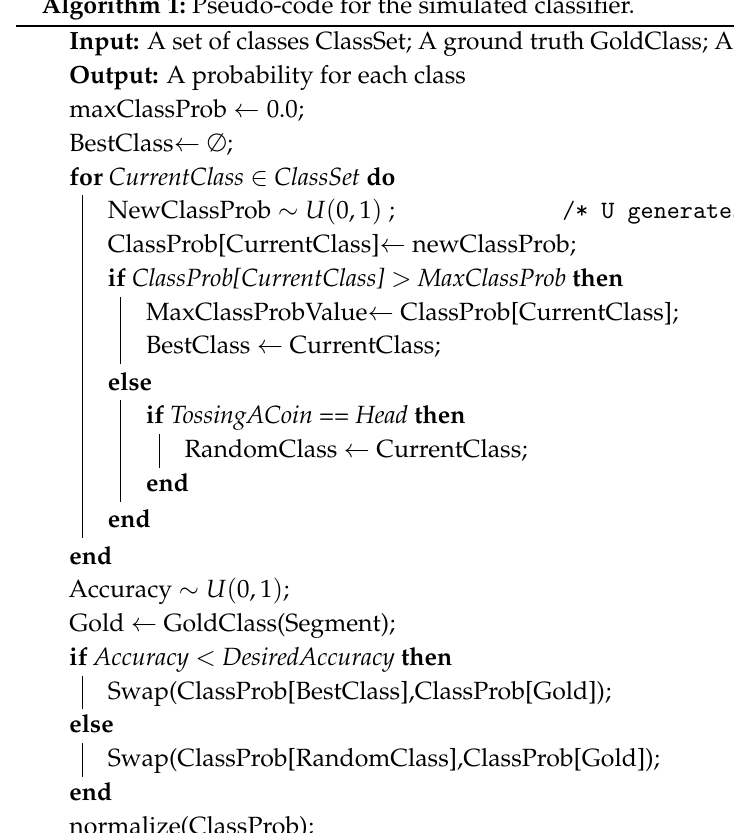
Algorithm 1: Pseudo-code for the simulated